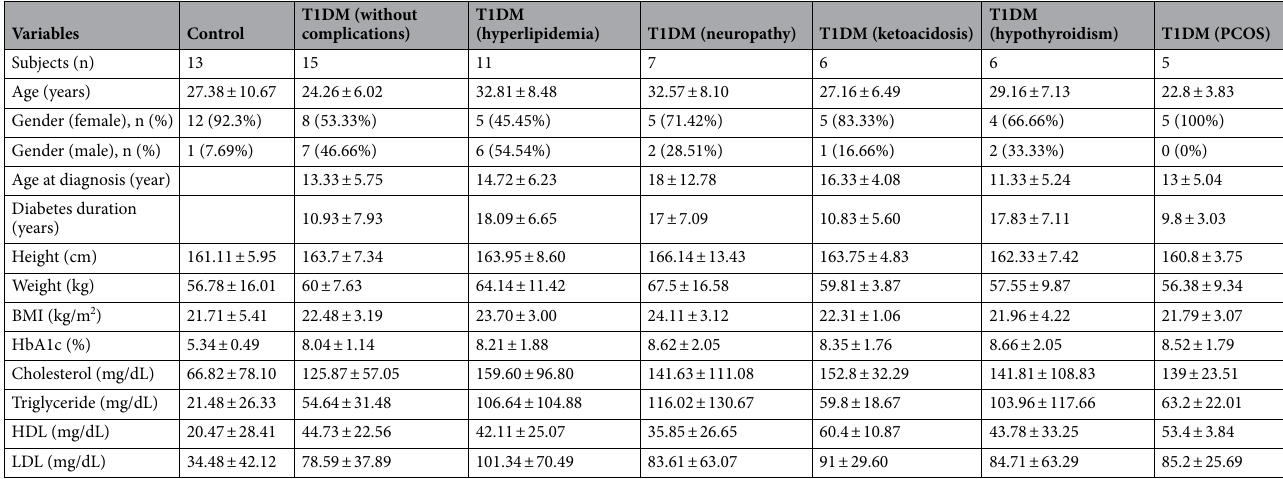
Table 2. Baseline demographic and clinical characteristics of the studied population: control, T1DM without complications and T1DM with complications. Control Group includes healthy subjects without diabetes; T1DM Group includes patients with T1DM without complications. Complication Groups include patients with T1DM complications (Hyperlipidemia, Neuropathy, Ketoacidosis, Hypothyroidism, PCOS).